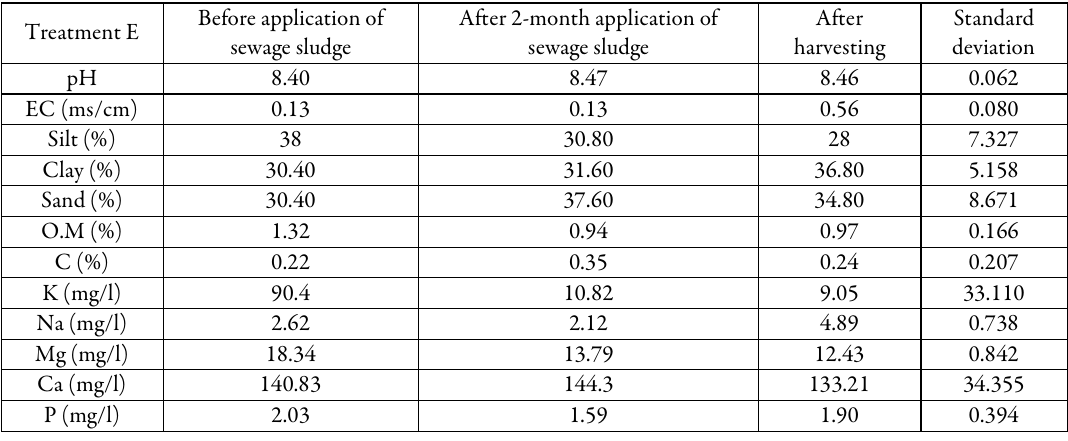
Table 6. Mean values of physicochemical parameters of soil with fertilizer before fertilization and after harvesting Before application of After 2-month application Treatment E sewage sludge